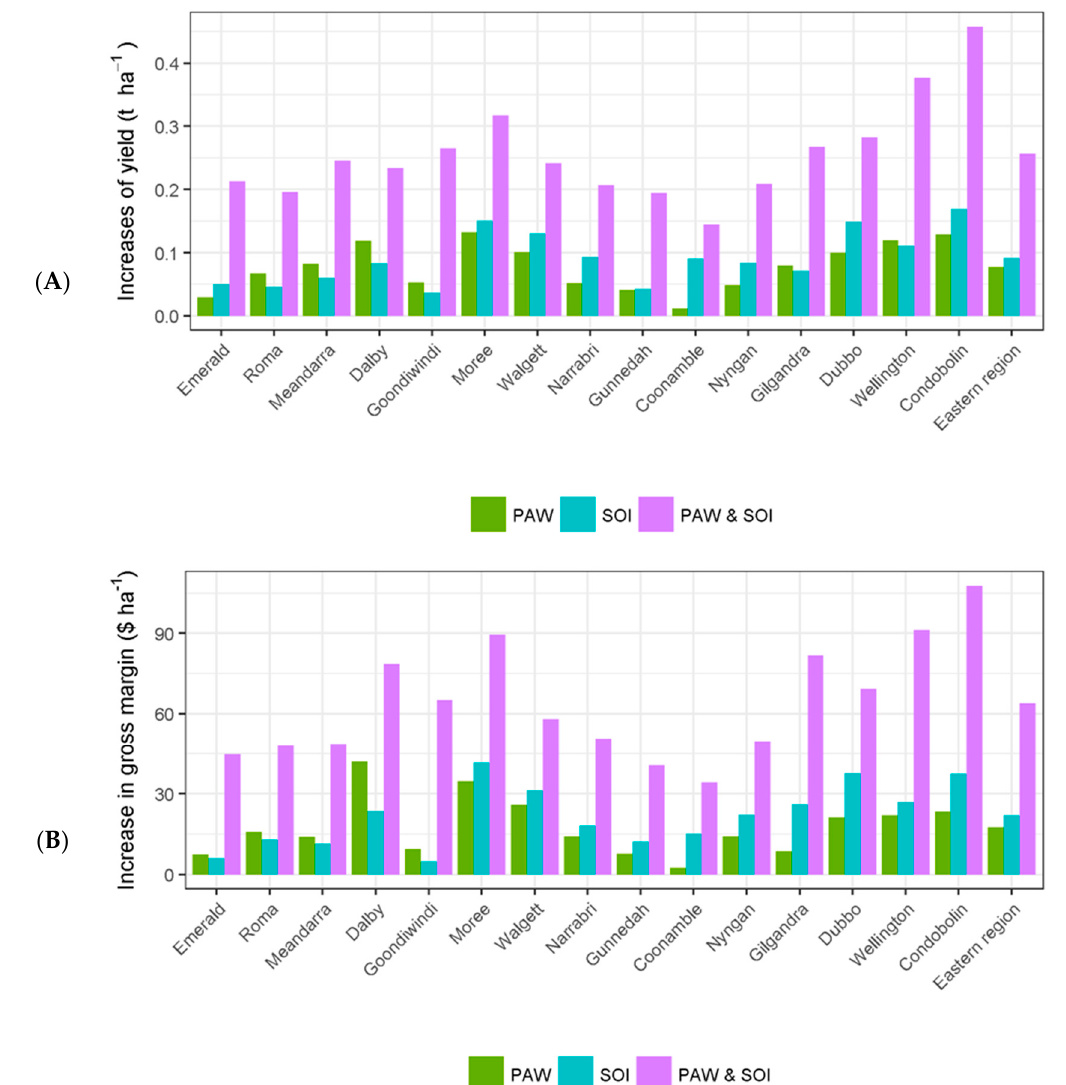
Figure 7. Increase in simulated yield ( A ) and gross margin ( B ) for tactical adaptation options compared to the fixed adaptation in each studied site and the whole Eastern wheatbelt. Increases in yield were averaged for all years from 1900 to 2016. The three tactical adaptation options correspond to optimise long-term yield for either (i) low/medium/high pre-sowing plant available water (PAW), (ii) each class of Southern Oscillation Index (SOI), or (iii) each combination of PAW group and SOI class.